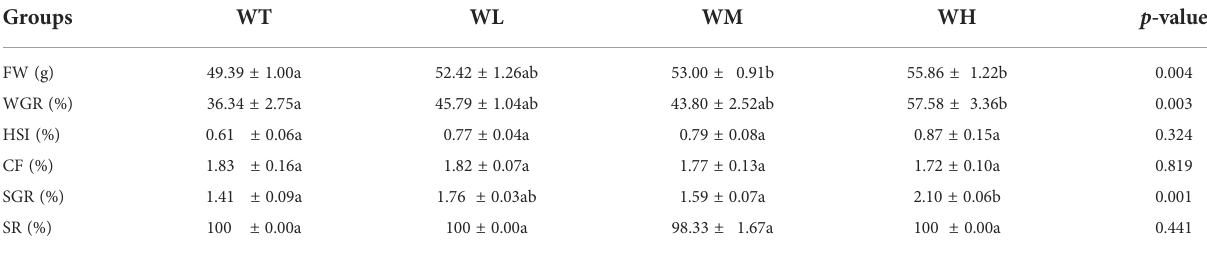
TABLE 2 Growth performance parameters of hybrid grouper cultured in seawater with added probiotics and in the control seawater. Groups